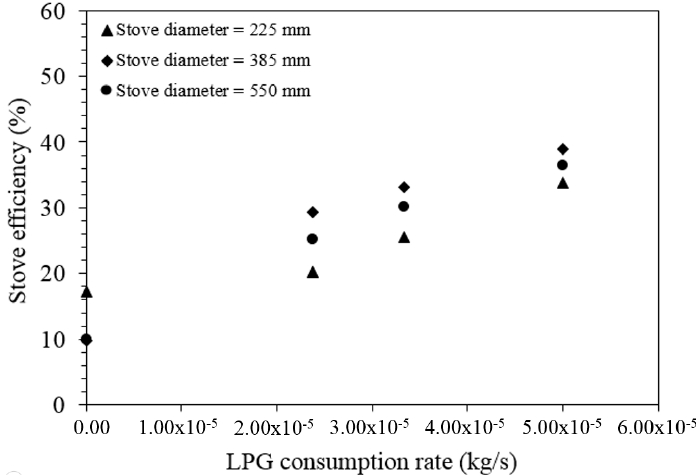
Figure 8. Relationship between stove efficiency and LPG flow rate.